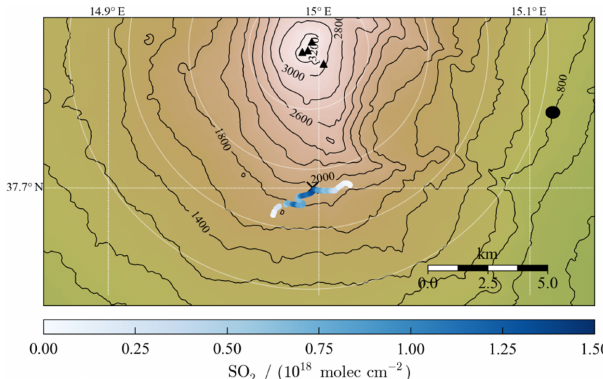
Figure 2. Topographic map of the southern slope of Mt. Etna. The background color shading corresponds to surface elevation with black contours in steps of 200m altitude change. The white cir- cular grid illustrates horizontal distances from the crater region in steps of 2.5km as indicated by the ruler in the lower right. The four active craters on the summit at about 3300m altitude are indi- cated by black triangles and the base station at Milo is illustrated by the black circle on the eastern slope. The blueish trajectory in the middle of the map shows the motion of the mobile observa- tory on 22 September, between 08:00 and 08:50hUTC (typical so- lar zenith angle SZA = 55 ◦ ) in the vicinity of Rifugio G. Sapienza (black cross). The color code is a rough measure for the observed SO 2 VCDs as indicated by the color bar. Note that SO 2 VCDs are plotted at the position of the observer at the time of measurement.